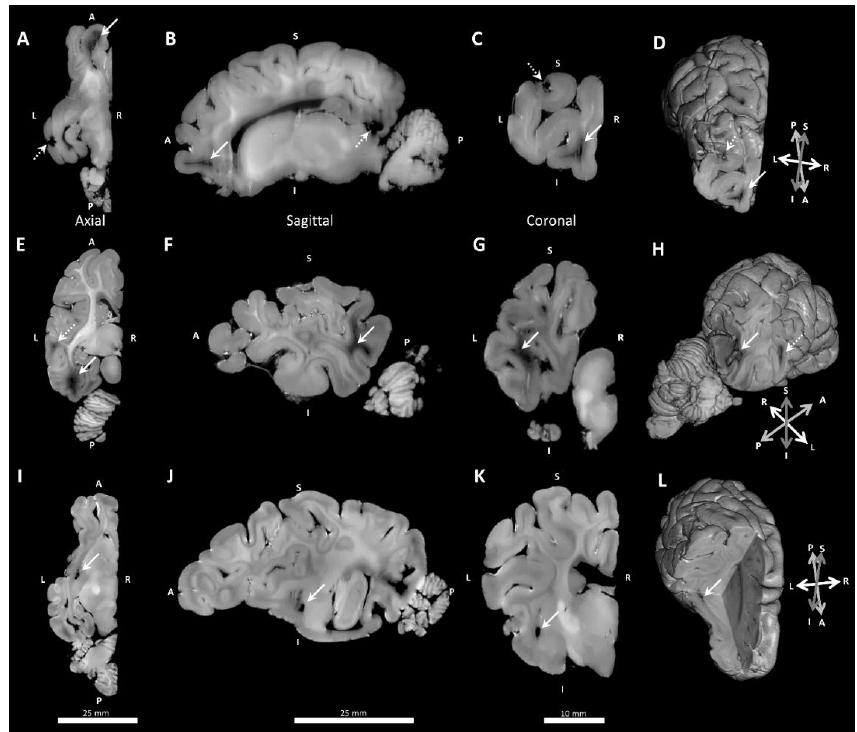
Figure 7. Example lesions in T1-weighted MRI images shown in orthogonal planes and with 3D rendering. ( A – D ) Frontal cortex white matter lesions (solid white arrows) and examples of susceptibility artefacts due to undissolved gas (stippled arrows). ( E – H ) Temporal lobe cortex lesion (stippled arrow) and occipital cortex white matter lesion (solid white arrow). ( I – L ) Deep cystic lesions (solid white arrows). Abbreviations: L, Left; R, Right; I, Inferior; S, Superior; A, Anterior; P, Posterior. Brain Sci. 2020 , 10 , x FOR PEER REVIEW